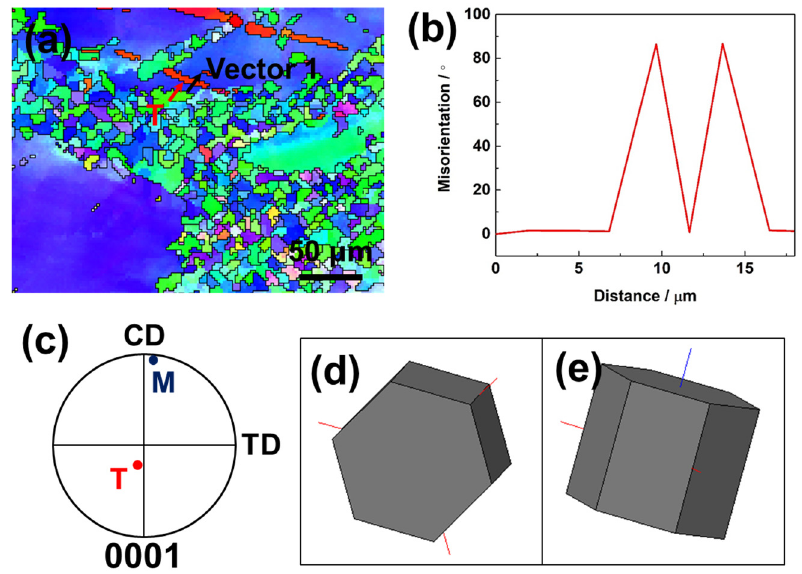
Figure 13. ( a ) EBSD IPF map of the alloy deformed at 300 °C/0.01 s − 1 , ( b ) changes of misorienta- tions along with Vector 1, ( c ) the orientations relationship on {0001} pole figures of twin grain T with its surrounding matrix grain and schematic diagram showing the lattice of ( d ) twin grain T and ( e ) matrix